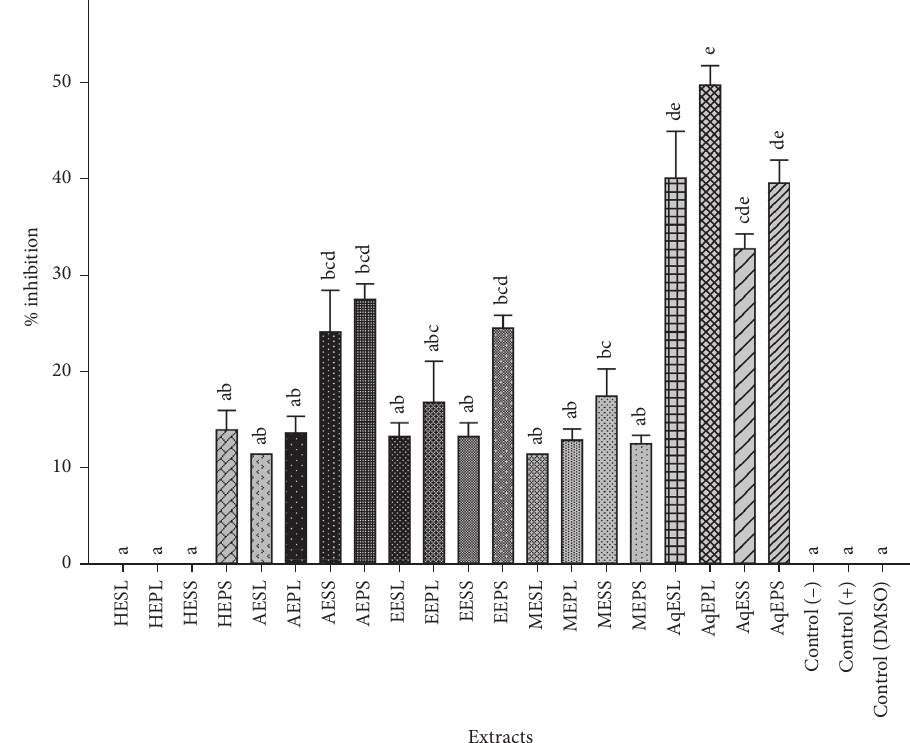
Figure 6: Inhibition percentage at day eight of incubation of the mycelial growth of C. fructicola in the presence of papaya and soursop leaf and seed extracts. Means with the same letter are not significantly different according to Tukey’s test ( P < 0 . 05).